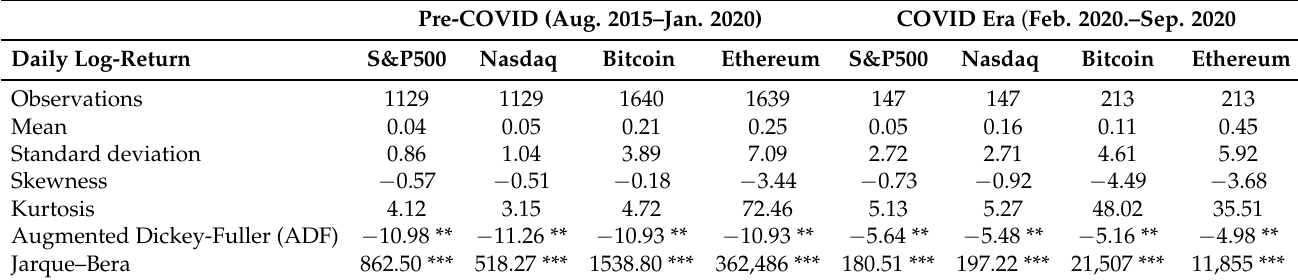
Table 1. Descriptive statistics.